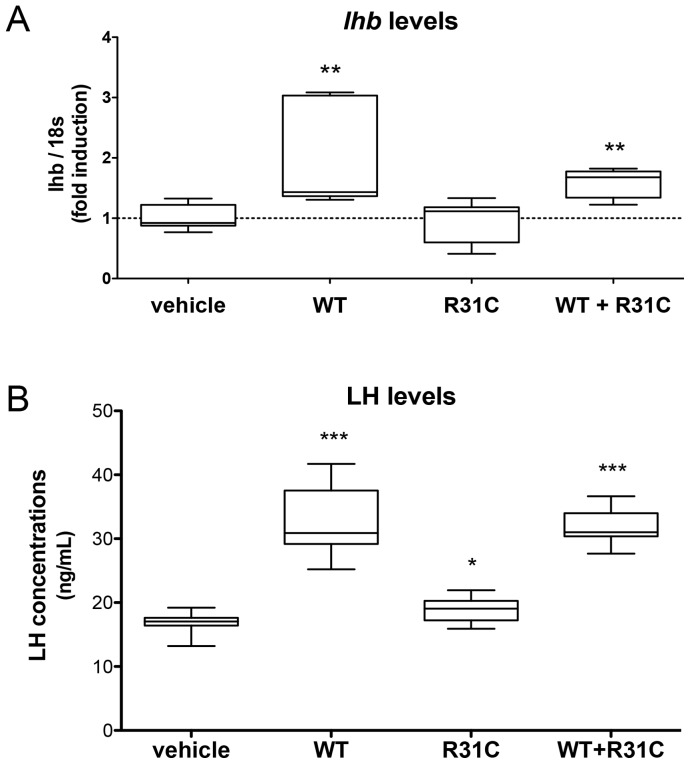
Effects of treatments on lhb transcription and LH secretion.(A) LbetaT2 cells were starved overnight in serum-free DMEM and treated either by 10 nM WT, R31C, 10 nM WT +10 nM R31C peptides or vehicle. After five hours treatment cells were lysed for RNA extraction (Trizol®). Mouse lhb levels were analyzed by quantitative real time RT-qPCR. Values are expressed as individual ratios on 18S and represented as fold induction on vehicle as means ± SEM, **p<0.01. This experience was conducted n = 7 times in duplicates. (B) LH concentrations from LbetaT2 cells culture media. Cells were starved overnight in serum-free DMEM and incubated with 10 nM WT, 10 nM R31C, 10 nM WT +10 nM R31C, or vehicle for 5 hours. LH levels were measured by a combined rat/mouse RIA. Values are expressed as individual values and as means ± SEM, *p<0.05, ***p<0.001. The experiment was conducted four times and each sample was assayed in duplicates.